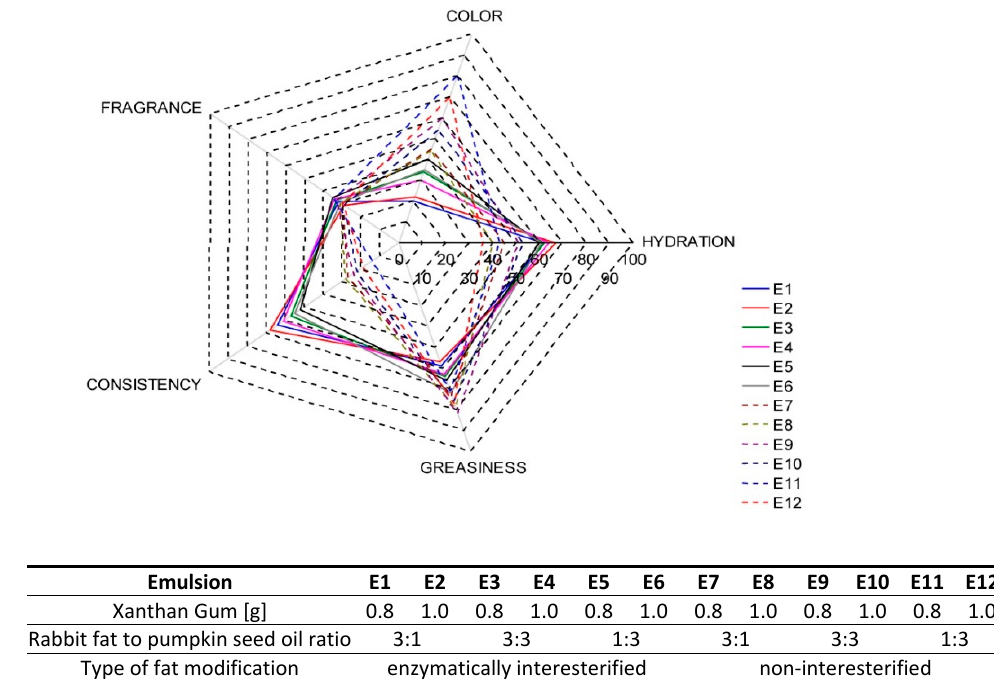
Figure 6 . Sensory profile of emulsions E1-E12 - evaluation of the sensory panel. Figure 6. Sensory profile of emulsions E1–E12—evaluation of the sensory